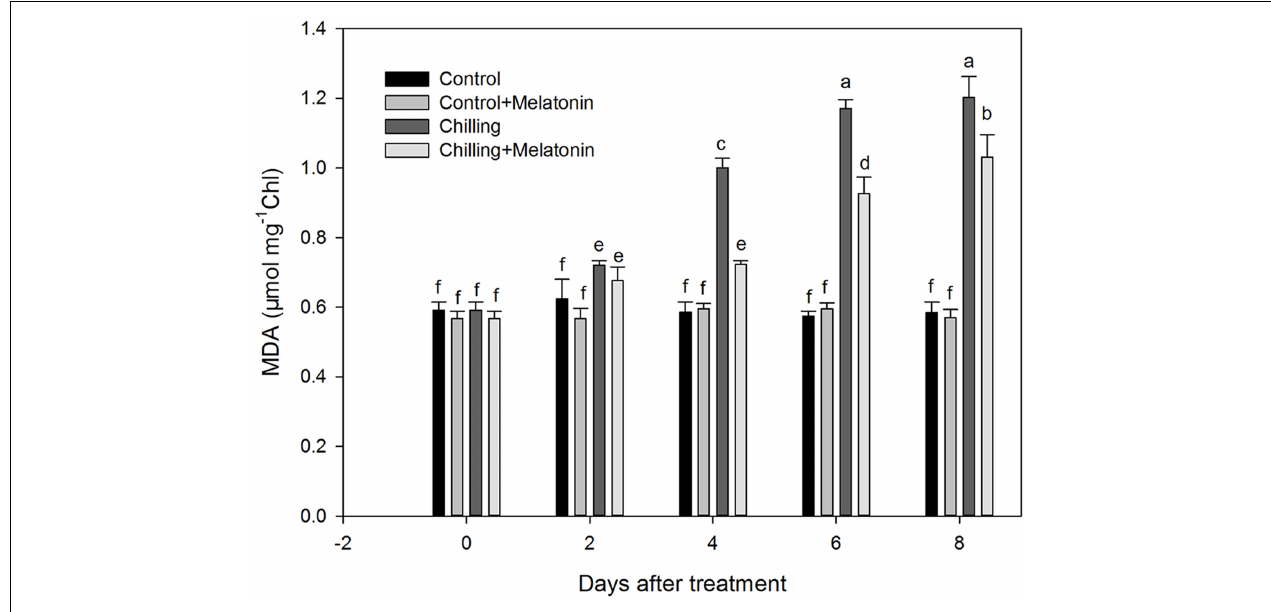
FIGURE 3 | Effects of exogenous melatonin on malonaldehyde (MDA) content of chloroplasts under chilling stress. Control (28/18 ◦ C); Control + Melatonin (200 µ M melatonin, 28/18 ◦ C); Chilling (15/8 ◦ C); Chilling + Melatonin (200 µ M melatonin, 15/8 ◦ C). Data are means ± SD of three replicates. Different letters indicate significant differences according to a Duncan’s multiple range test ( P <